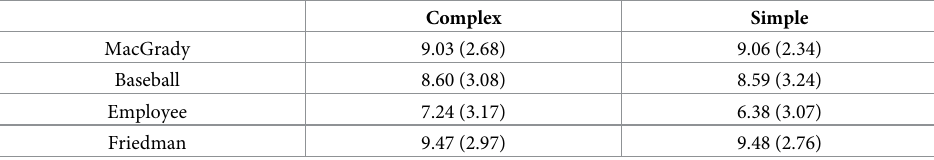
Table 4. Flesch-Kincaid score.